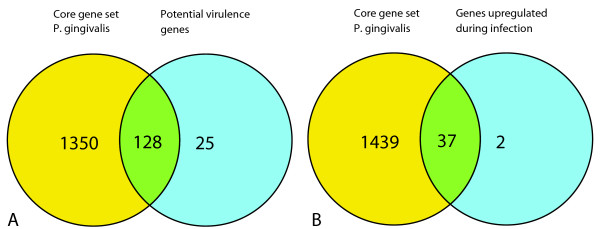
Virulence associated genes in the conserved core genome of P. gingivalis. A. 153 potential virulence genes from the genome annotation of W83 combined with the conserved core genome of P. gingivalis [29]. B 39 genes known to be up-regulated during infection combined with the conserved core genome of P. gingivalis [46,47]. The number in the overlapping part of the circles is the number of potential virulence associated genes that was found in the conserved core genome of P. gingivalis.